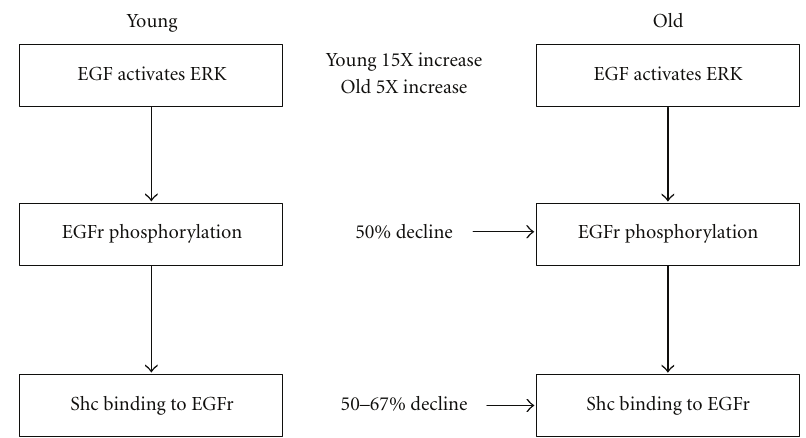
Figure 5: E ff ect of age on hepatic EGF receptor activation. Data derived from [30, 31].